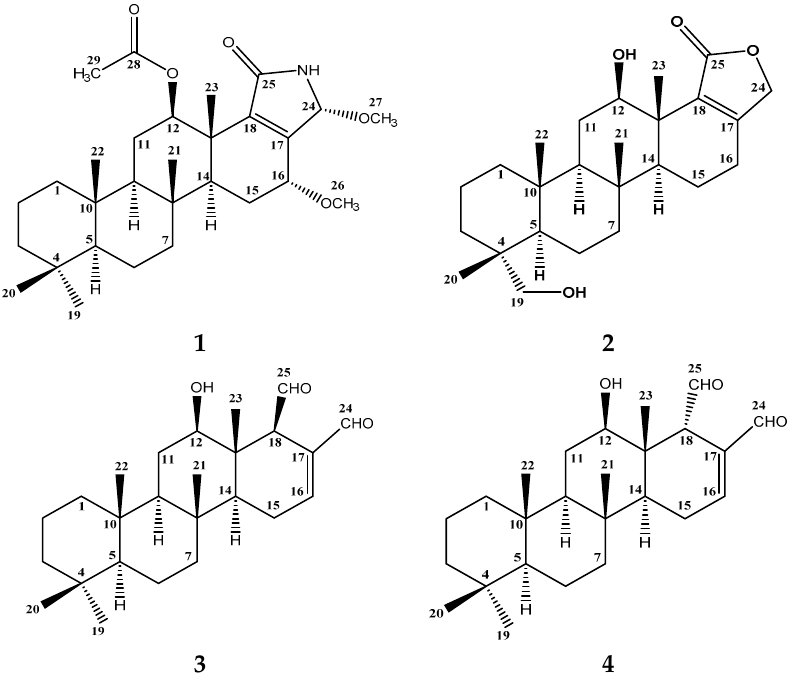
Figure 1. Structure of isolated scalarane sesterterpenes 1 – 4 .